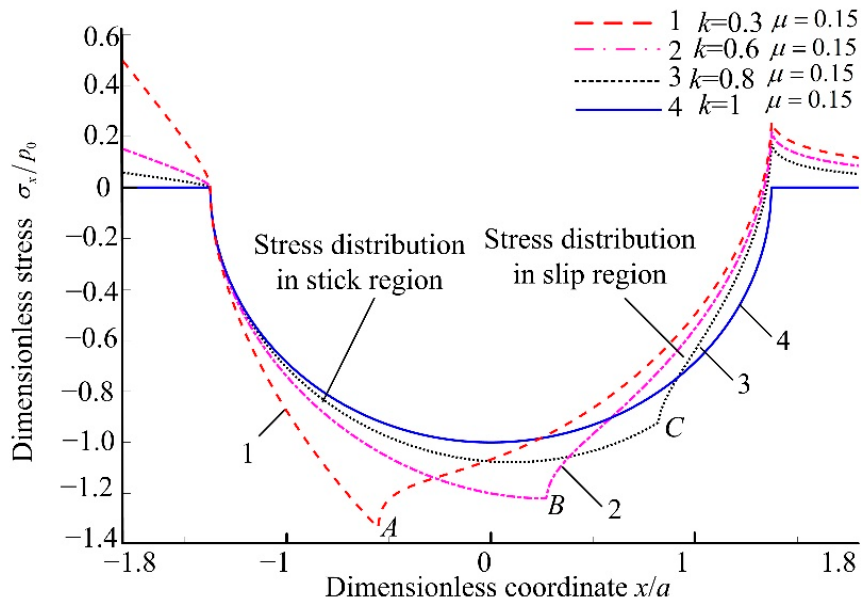
Figure 8. Stress σ x / p 0 for different values of k.